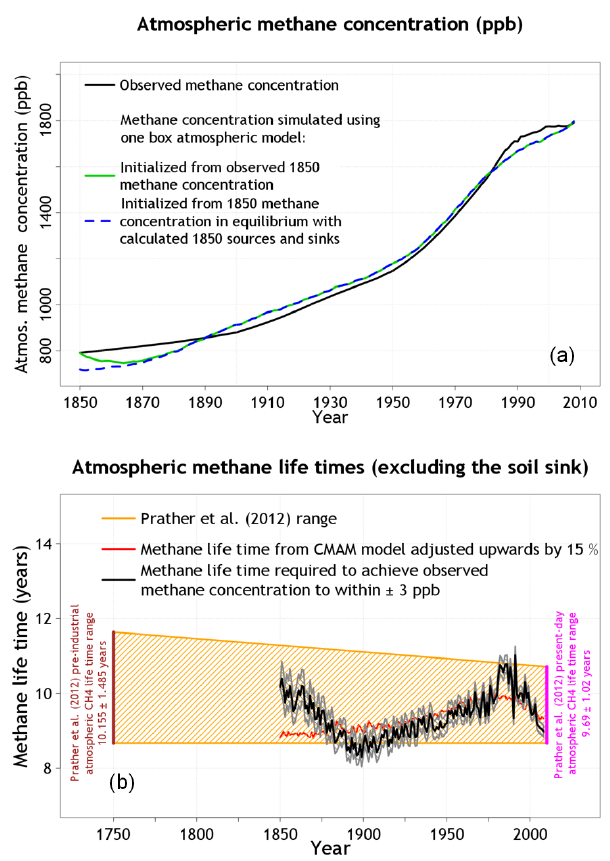
Figure 4. Comparison of simulated methane concentration over the historical period with its observation-based estimates ( a ). The sim- ulation may be initialized from the 1850 observed methane concen- tration (solid green line) or from an 1850 concentration that is in equilibrium with 1850 specified methane sources and sinks (dashed blue line) as explained in Sect. 3.2. Panel (b) compares the methane lifetimes required to achieve the observed increase in methane con- centration over the historical period (black line) to within ± 3ppb (shaded area between grey lines) with observation-based estimates of atmospheric methane lifetime based on Prather et al. (2012) and the adjusted atmospheric methane lifetime from